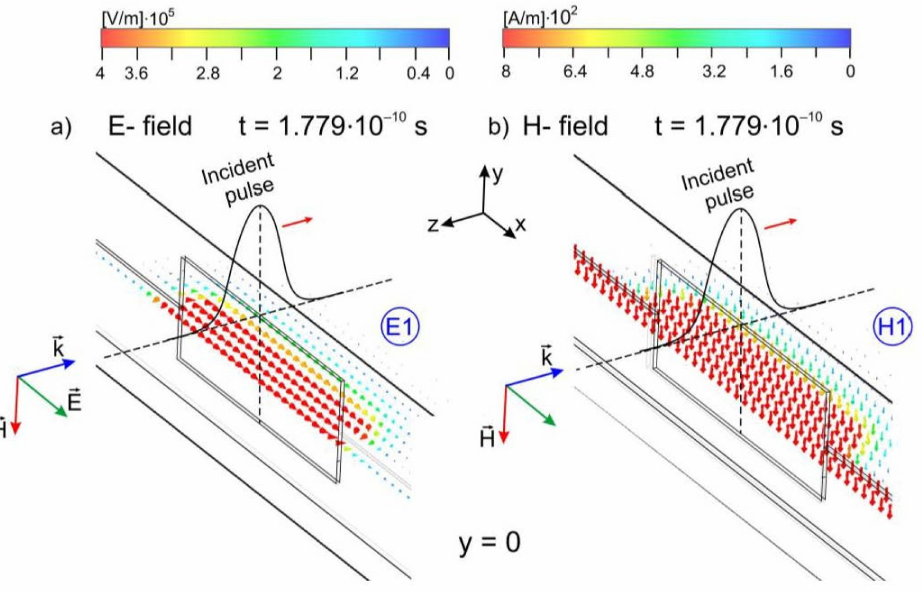
Figure 7. Associated electric E1 ( a ) and magnetic H1 ( b ) field structures in the plane xz (y = 0) at t = 0.1779 ns (i.e., when the incident pulse maximum passes the enclosure front wall plane). Vector shows the propagation direction of the EM incident pulse. Retrieved from Figure